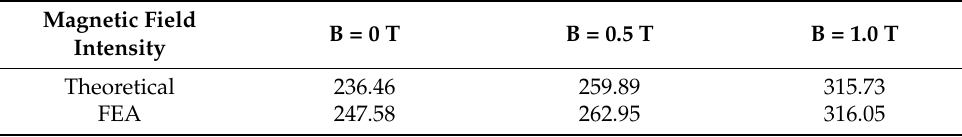
Figure 9. Frequency response for different magnetic fields. Table 4. Natural frequency under different magnetic